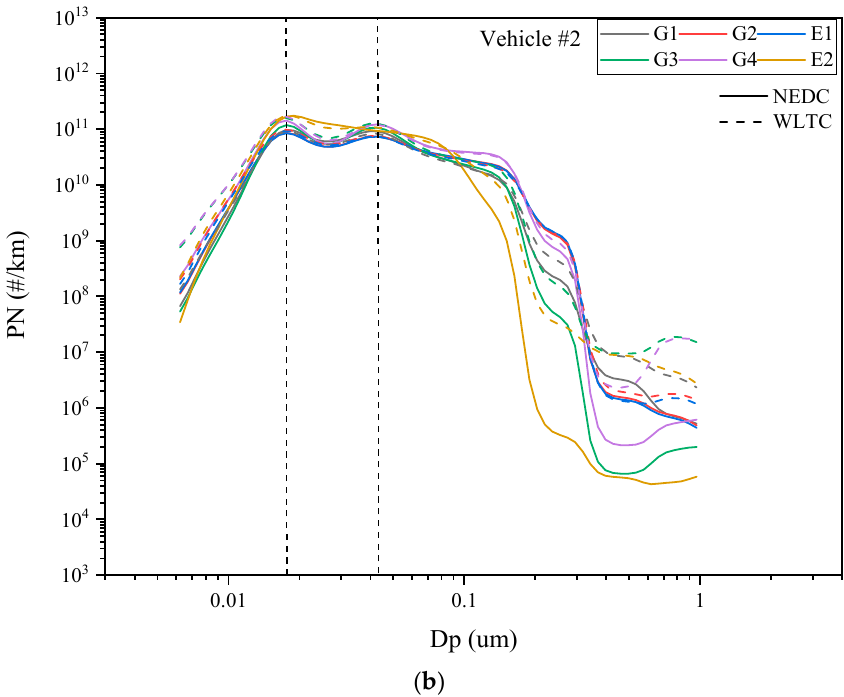
Figure 8. EFs of particles with different particle sizes: ( a ) Vehicle #1; ( b ) Vehicle #2.